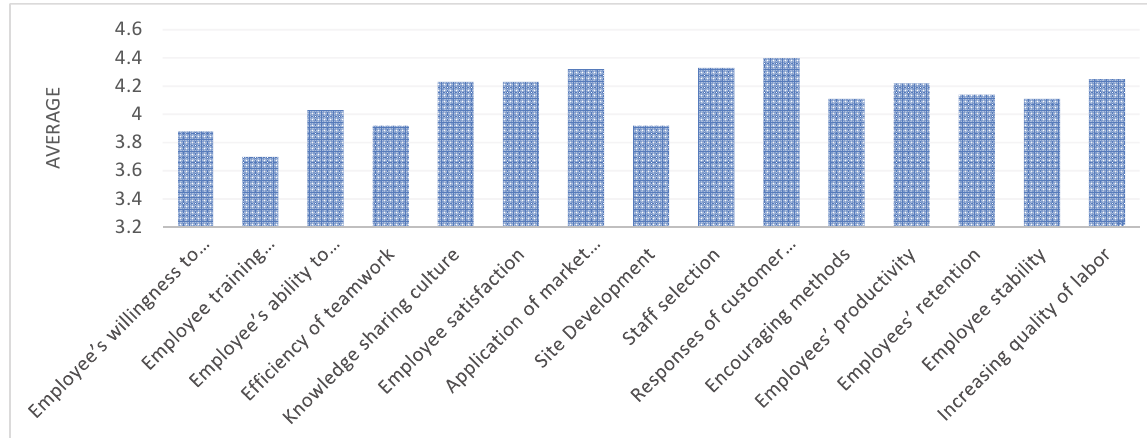
Fig. 9. Indicators of growth and learning construct and their